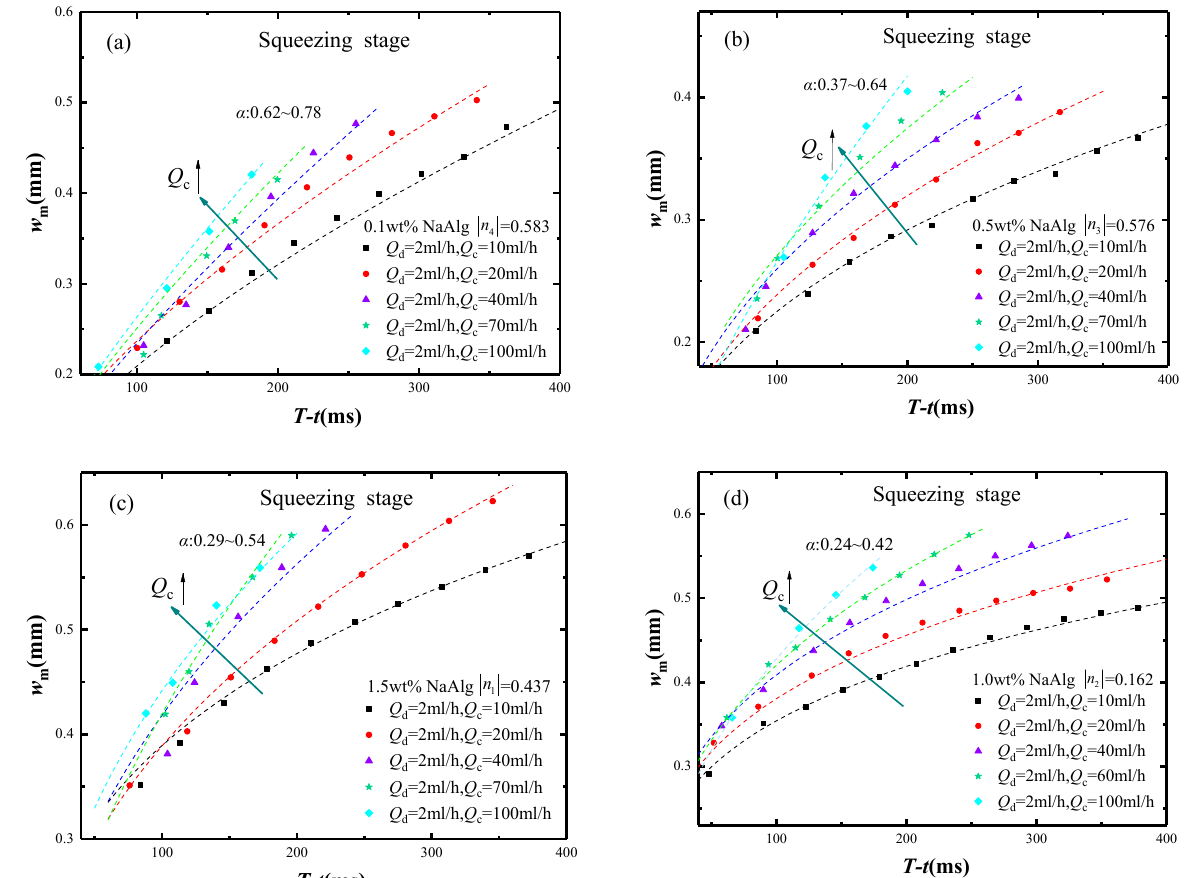
Figure 8. The relationship between wm and T − t with different Q d / Q c in the squeezing stage, ( a ) | n 4 | = 0.583, ( b ) | n 3 | = 0.576, ( c ) | n 1 | = 0.437 and ( d ) | n 2 | = 0.162.